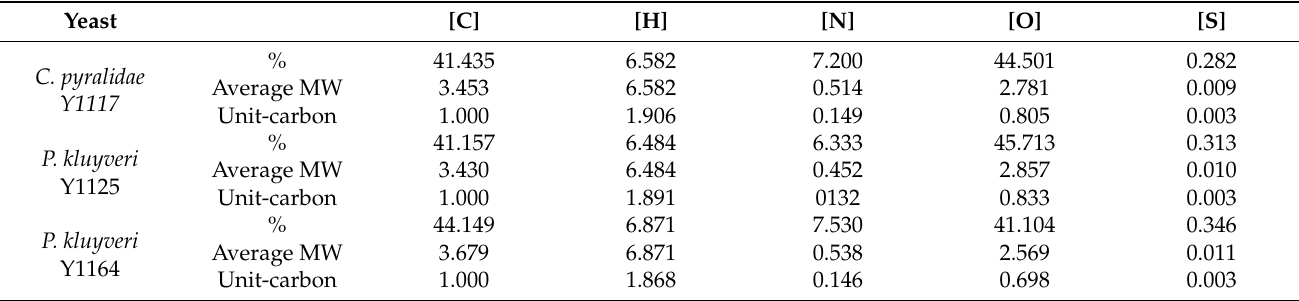
Table 3. Elemental analysis, average molecular weight, and unit carbon mole of Candida pyralidae Y1117, Pichia kluyveri Y1125, and P. kluyveri Y1164 during biopreservation compound production using grape pomace extract as fermentation medium. The values presented in the table are the average of three replicates.